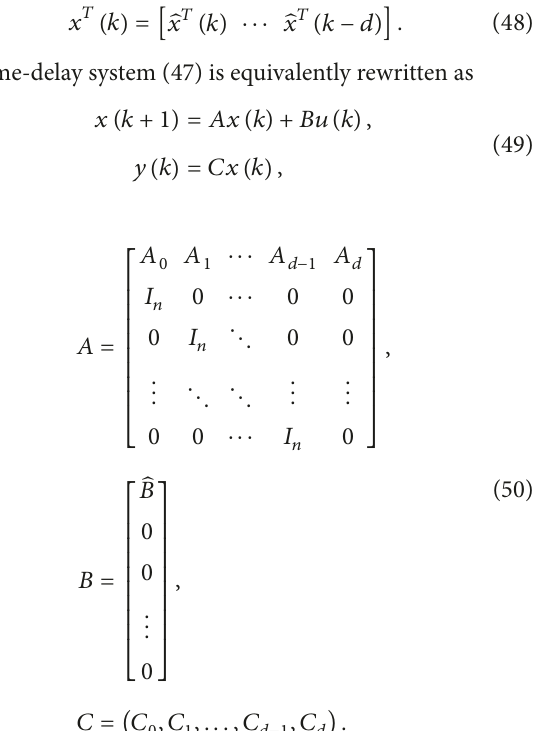
Algorithm 7 is restated in the following lines to tackle the output feedback EAP problem for decentralized control systems. Algorithm 14 (three-term CG method for the decentralized output feedback